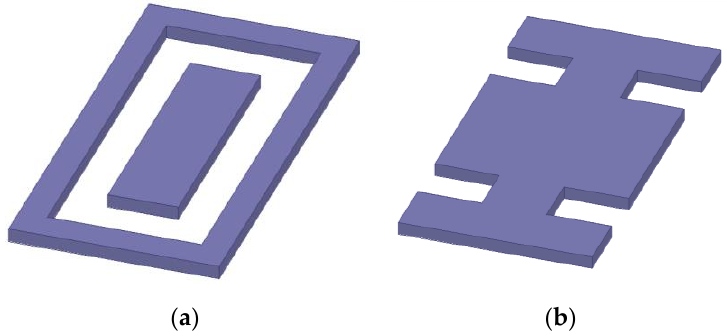
Figure 14. Iteration process of optimization algorithm used in rectangular coupler.